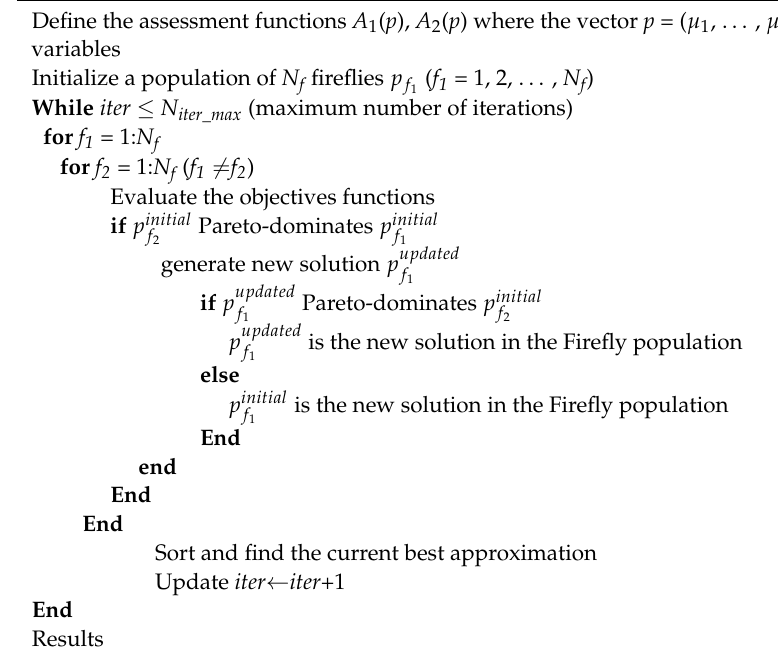
Algorithm 1 Double objective firefly optimization algorithm